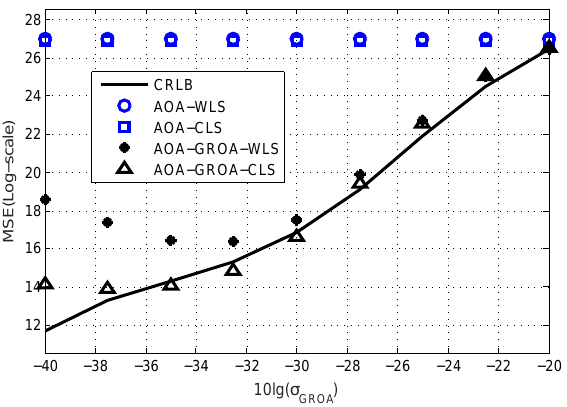
Figure 4. Average MSE results of AOA-only WLS, AOA-only CLS, AOA-GROA WLS and AOA-GROA CLS methods, σ GROA varies, whereas σ AOA = 10 − 2 radian and σ s = 10 − 2